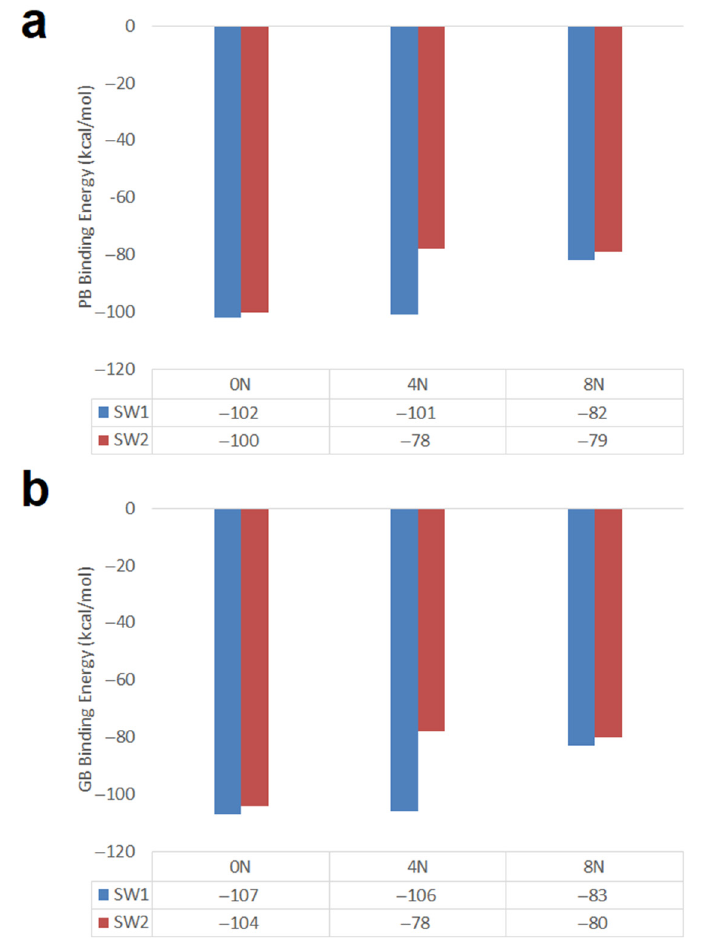
Figure 10. Representation of the PB and GB DOX-CNT binding energies for nitrogen-doped and undoped zigzag (18,0) nanotubes having one and two Stone–Wales defects. ( a ) PB binding energy; ( b ) GB binding energy.